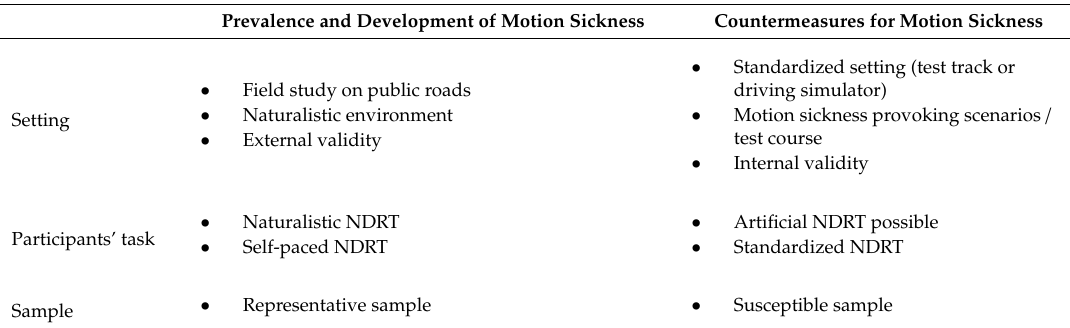
Table 2. Overview of the recommendations for studies concerning the two main research